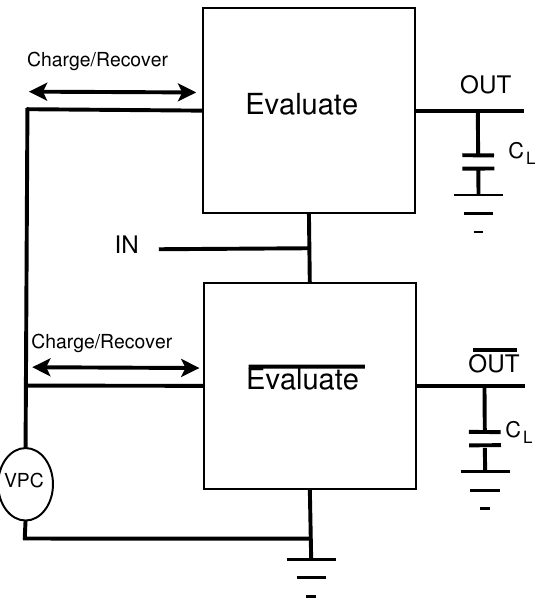
Figure 2. General Structure of Adiabatic Logic Circuits. Side-channel attacks attempt to steal information from a device’s inherent charac- teristics such as power consumption [5], timing [6], etc. In this article, we will focus on side-channel attacks in the form of power analysis attacks. Of the power analysis attacks, the Correlation Power Analysis Attack (CPA) is widely used because of its ability to target both symmetric and nonsymmetric cryptographic algorithms [21]. Different inputs of a circuit will result in different power consumption [5]. With this information, an attacker can measure hundreds of thousands of power profiles with controlled inputs to steal the secure encryption key. Masking and elimination are two methods to defend against power analysis attacks [22]. Masking aims to minimize correlation between data and power consumption such as in the proposed Bus-Invert Coding [23]. To defend against the CPA attack, we designed our circuits using a technique known as elimination [22]. Elimination aims to remove any variations in power consumption, so that each operation has uniform power consumption and thus no information leakage. An example of uniform power consumption can be seen in Figure 3, which shows the uniform current of a two and four-phase adiabatic